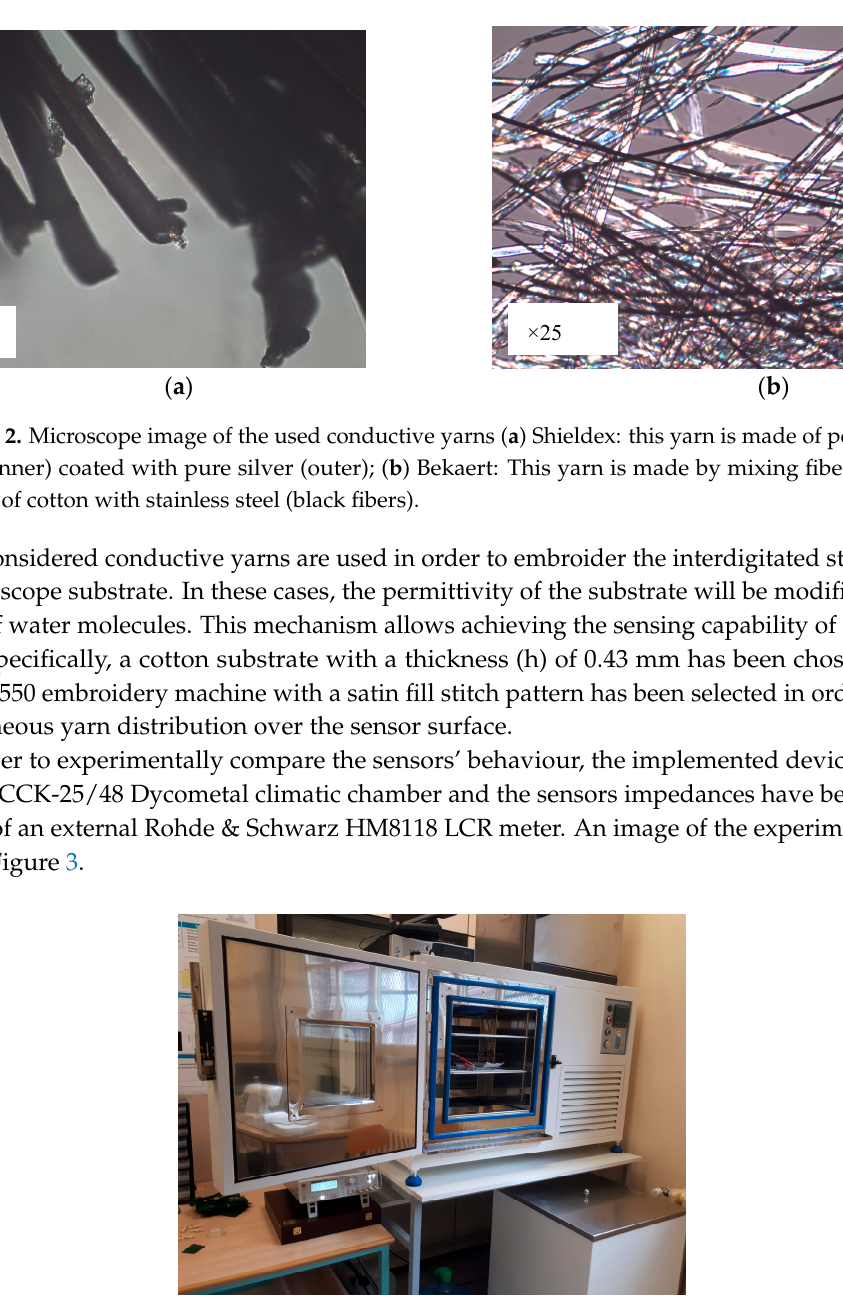
Figure 3. Image of the experimental setup.